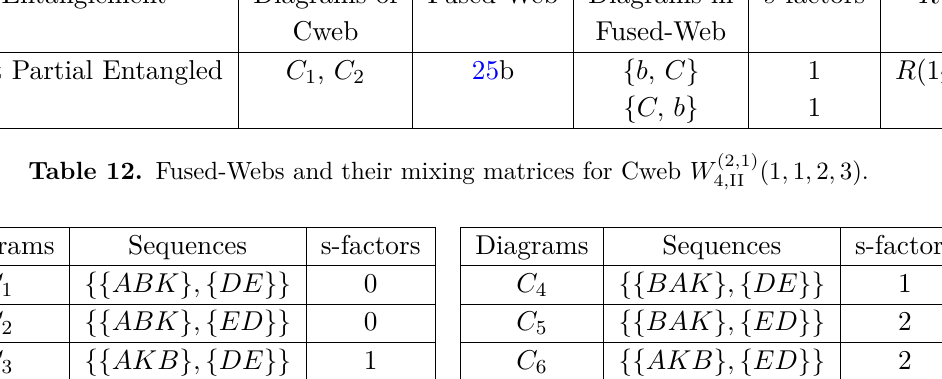
Table 13. Normal ordered diagrams of Cweb W (2 , 1)